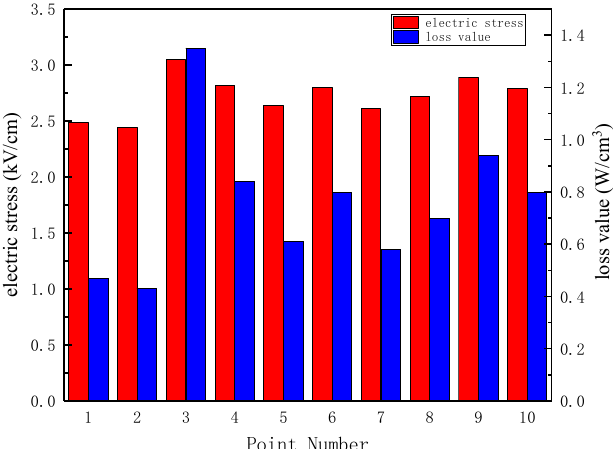
Figure 13. Maximum electric stress and loss for various lengths of corona protection layer.